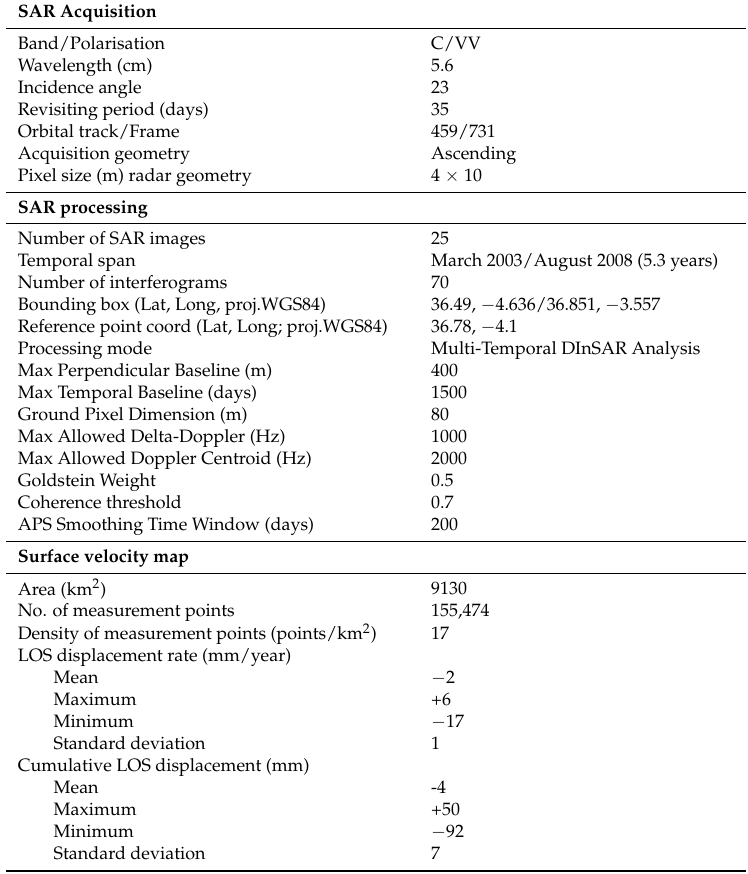
Table 1. Main characteristics of the SAR datasets, processing and surface velocity